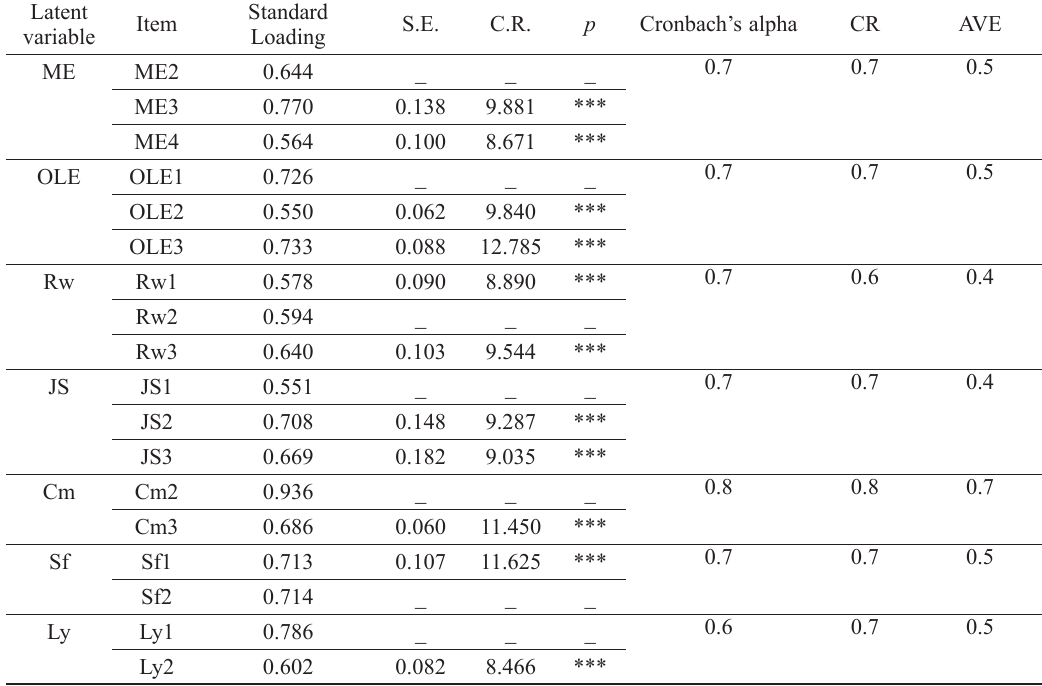
Table 3. Results of the measurement model Latent